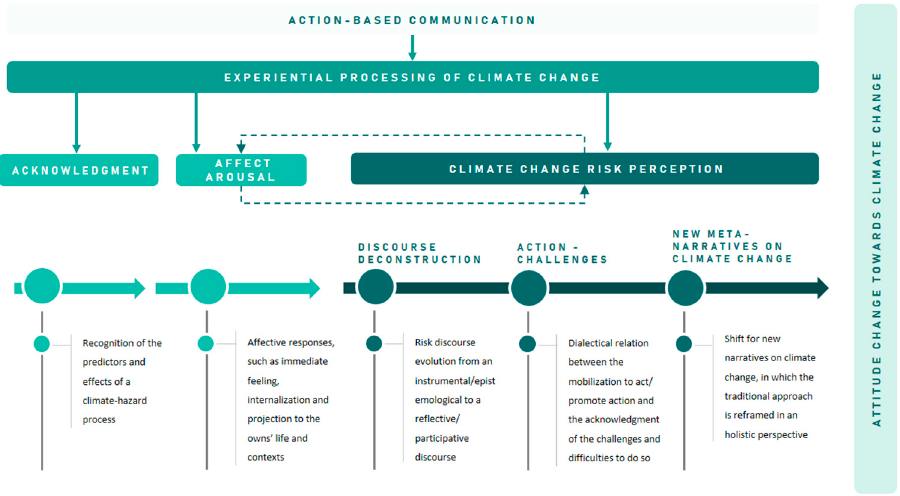
Figure 4. Climate change attitude change process enhanced by climate change action-based communication tools .